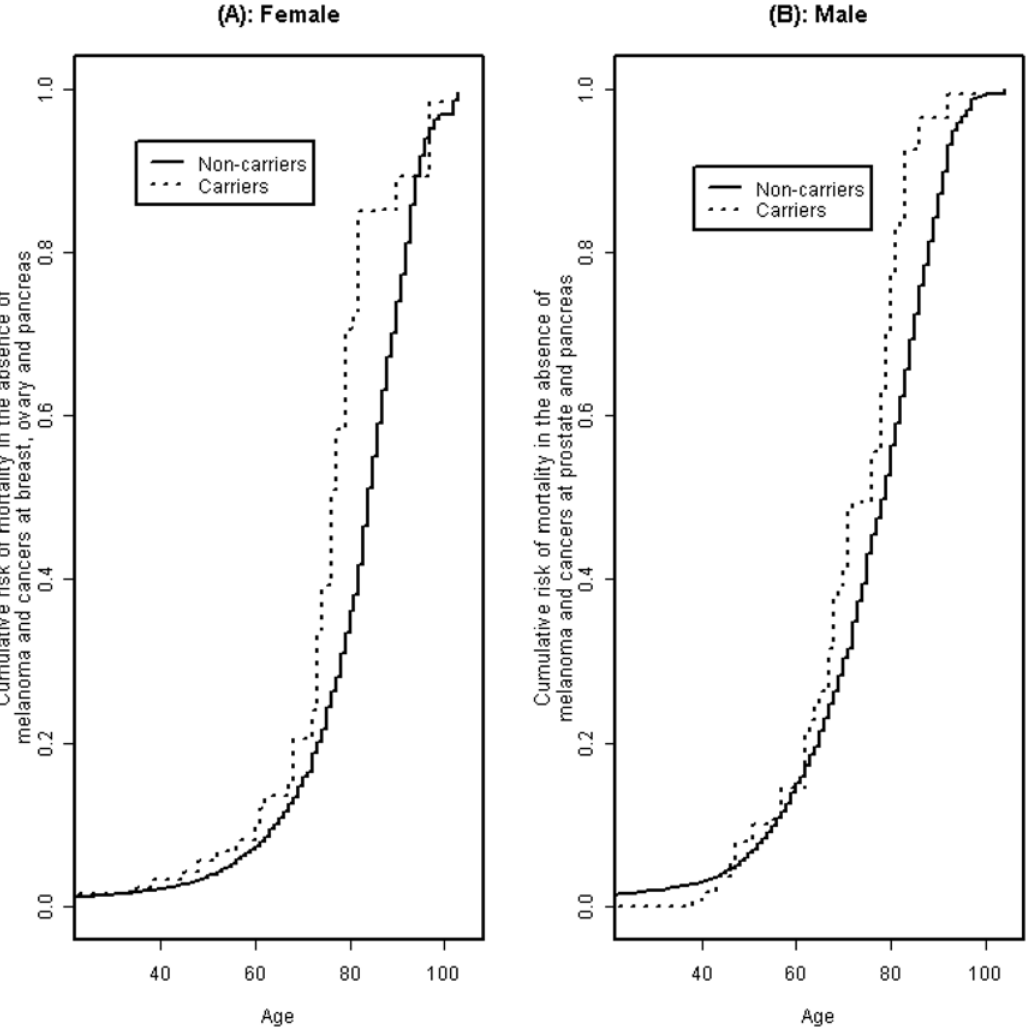
Figure 2. Cumulative incidence of mortality risk in the absence of established BRCA mutation-associated cancers. Estimated cumulative risk of mortality among females in the absence of breast, ovarian, pancreatic cancer, and melanoma is shown in panel A. Panel B shows the estimated cumulative risk of mortality among males in the absence of melanoma, prostate, and pancreatic cancer.